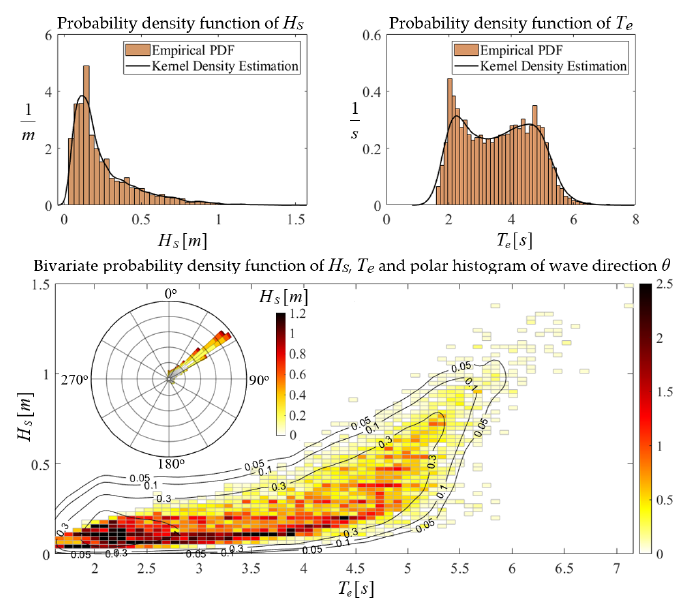
Figure 7. Annual distribution of wave parameters at the nearshore point TP in the Pagasitikos Gulf region.